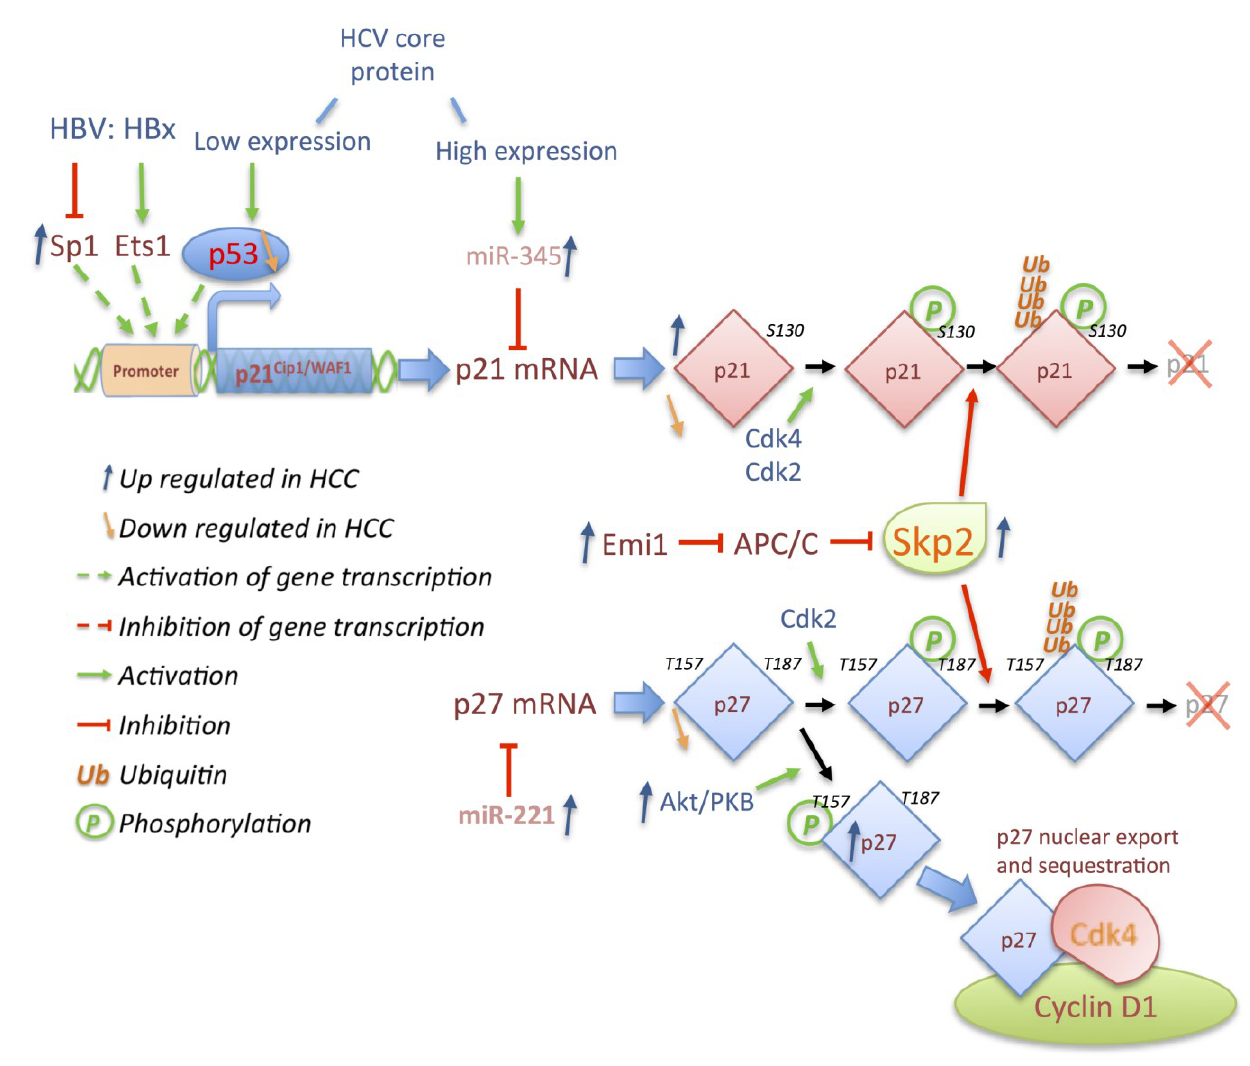
Figure 7. Cdk inhibitors p21 and p27 are deregulated in HCC. Low expression level of HCV expression core protein activates p53, which induces expression of p21 while high expression level of its mature form activates miR-345 targeting p21 mRNA. HBV X protein (HBx) results in bivalent actions on the transcription of the p21 gene by activating Ets1 or repressing Sp1 transcription factors. p27 mRNA is targeted by miR-221, which is often upregulated in HCC. p21 and p27 are phosphorylated by Cdk2 or Cdk4 respectively on S130 and T187 and ubiquitinated by Skp2 resulting in p21 and p27 degradation. Skp2 is targeted for degradation by the APC/C complex, itself regulated by Emi1, which is frequently overexpressed in HCC like Skp2. p27 is not only down regulated in HCC, its overexpression is a result of phosphorylation on T157 by Akt/PKB, leading to export of p27 to the cytoplasm where it is sequestered by Cdk4/cyclin D